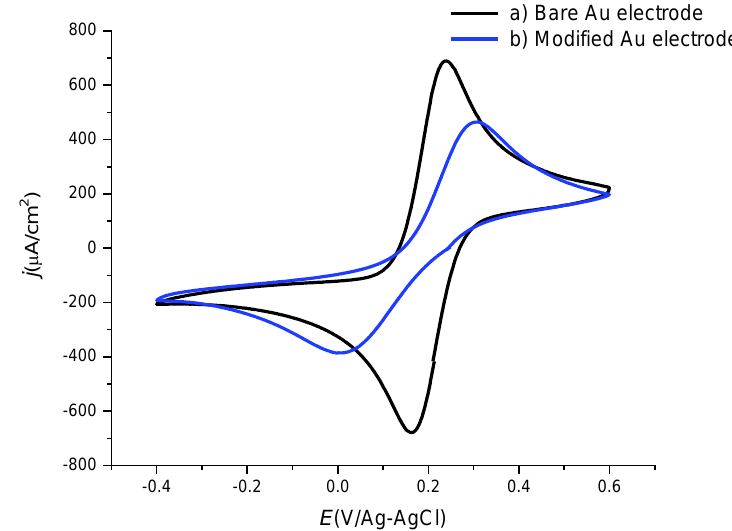
Figure 2. Cyclic voltammetry of 2.5 mM Fe(CN) 63 − /Fe(CN) 64 − in the presence of 0.1 M phosphate buffer, pH 7.2, scan rate 50 mVs − 1 obtained with (a) bare Au electrode and (b) after modification with [B 12 H 11 SH] 2 −